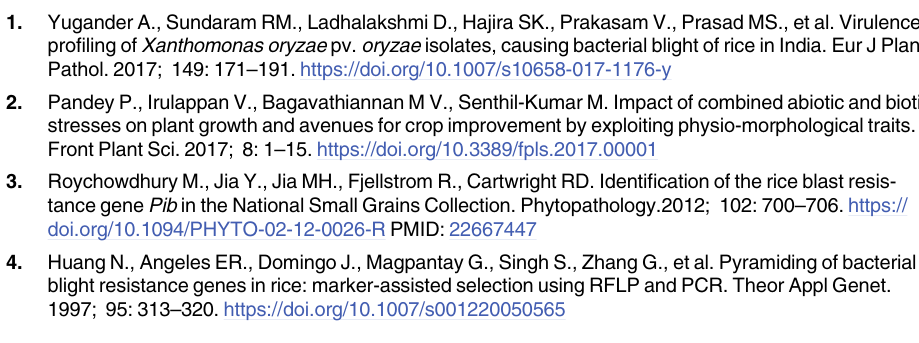
S3 Table. Screening of selected intercross (ICF and BB disease during Rabi , 2014–15 season at different